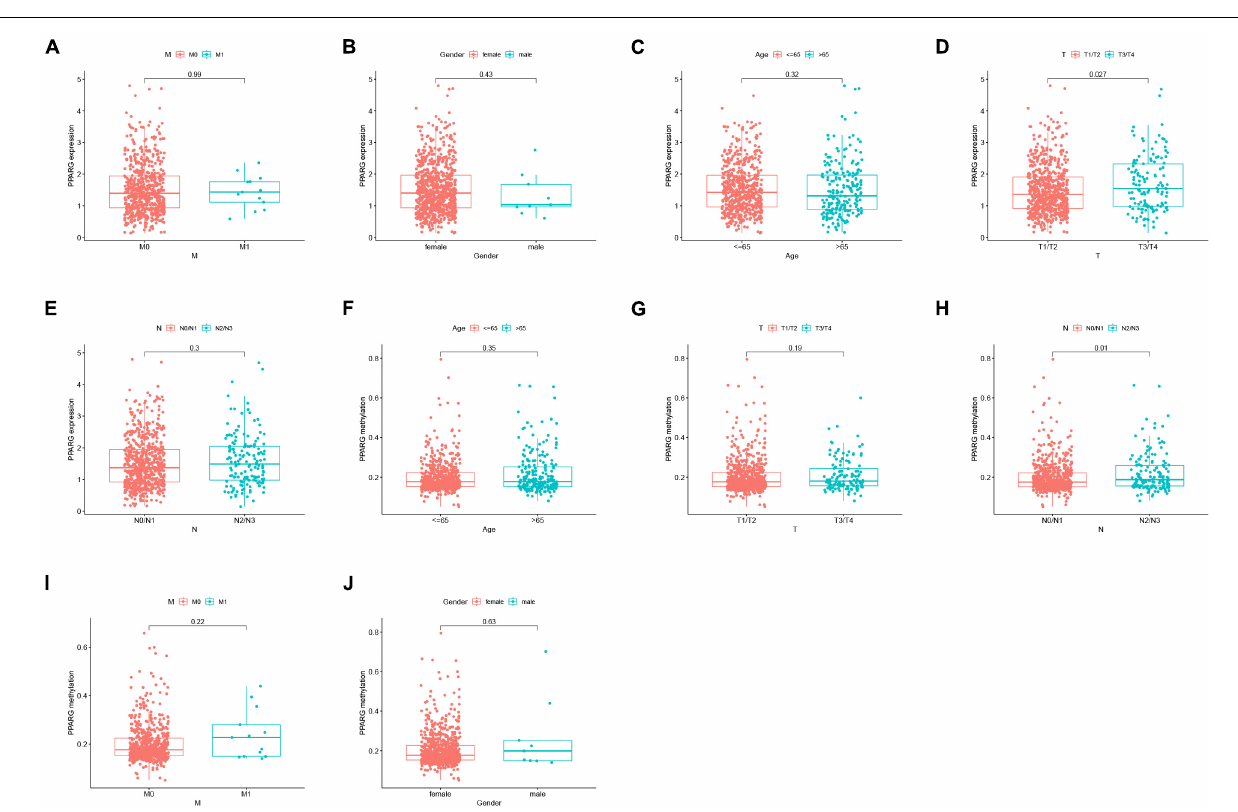
Frontiers in Genetics |